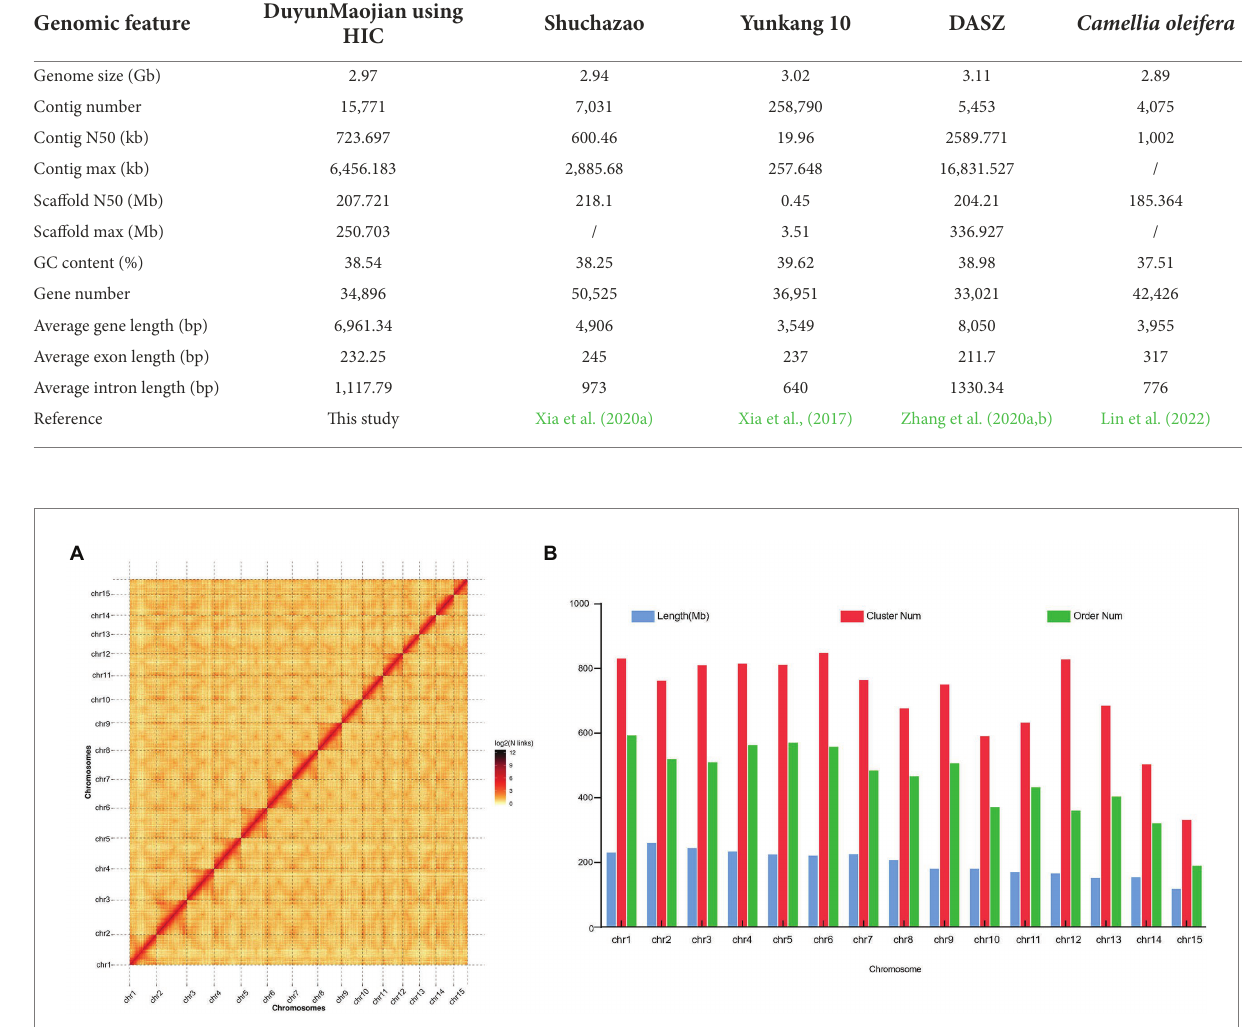
FIGURE 2 Hi-C heatmap based on the chromosome-scale assembly of the DuyunMaojian tea plant genome. (A) The heatmap represents the contact matrices generated by aligning the Hi-C data to the chromosome-scale assembly of the DuyunMaojian tea plant genome. (B) The assembly data statistics of each chromosome of the DuyunMaojian tea plant genome resulting from